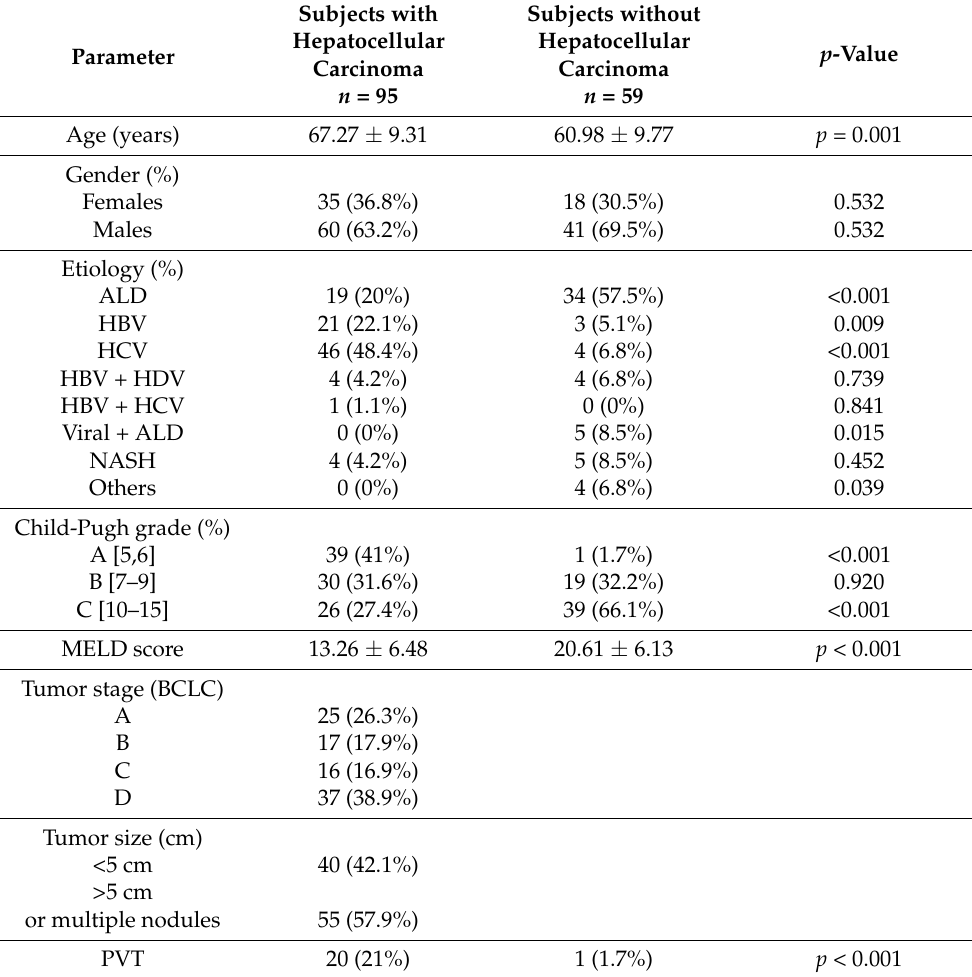
Table 1. The demographic and clinical characteristics of the patients.